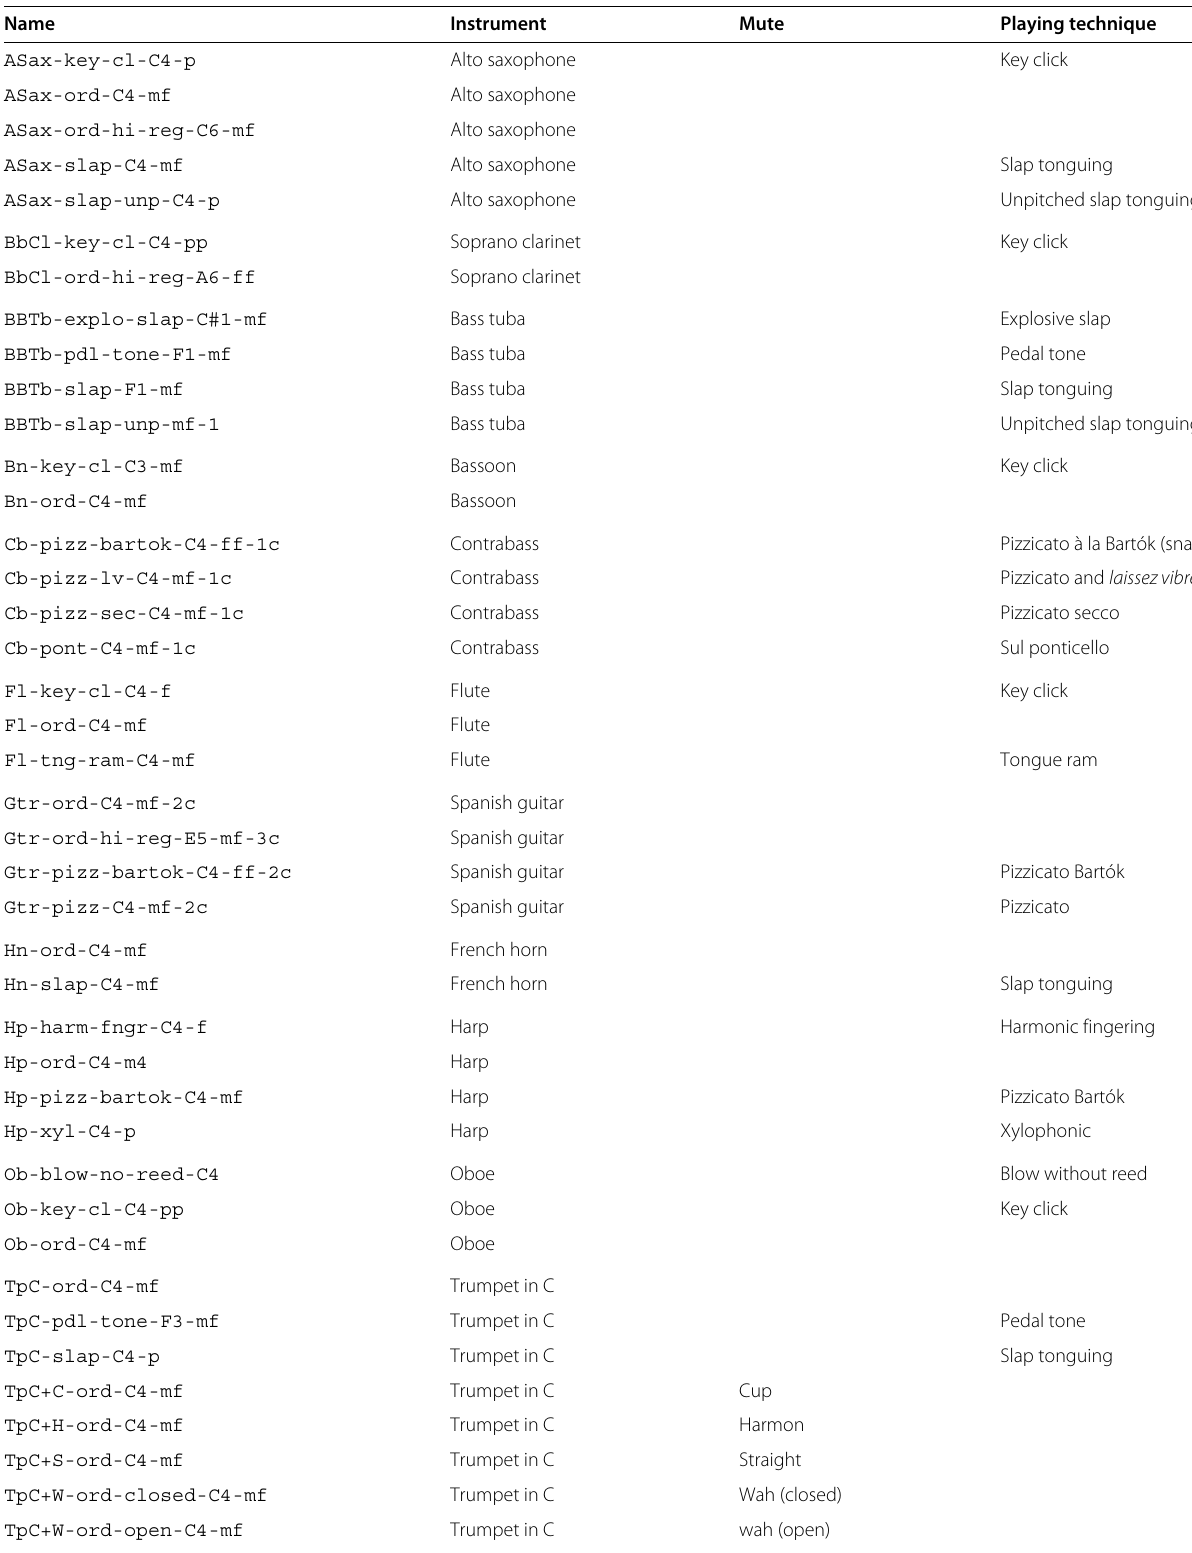
Table 1 Full list of audio stimuli (1/2). In each instrument, a blank space in the rightmost column denotes the ordinary playing technique ( ordinario